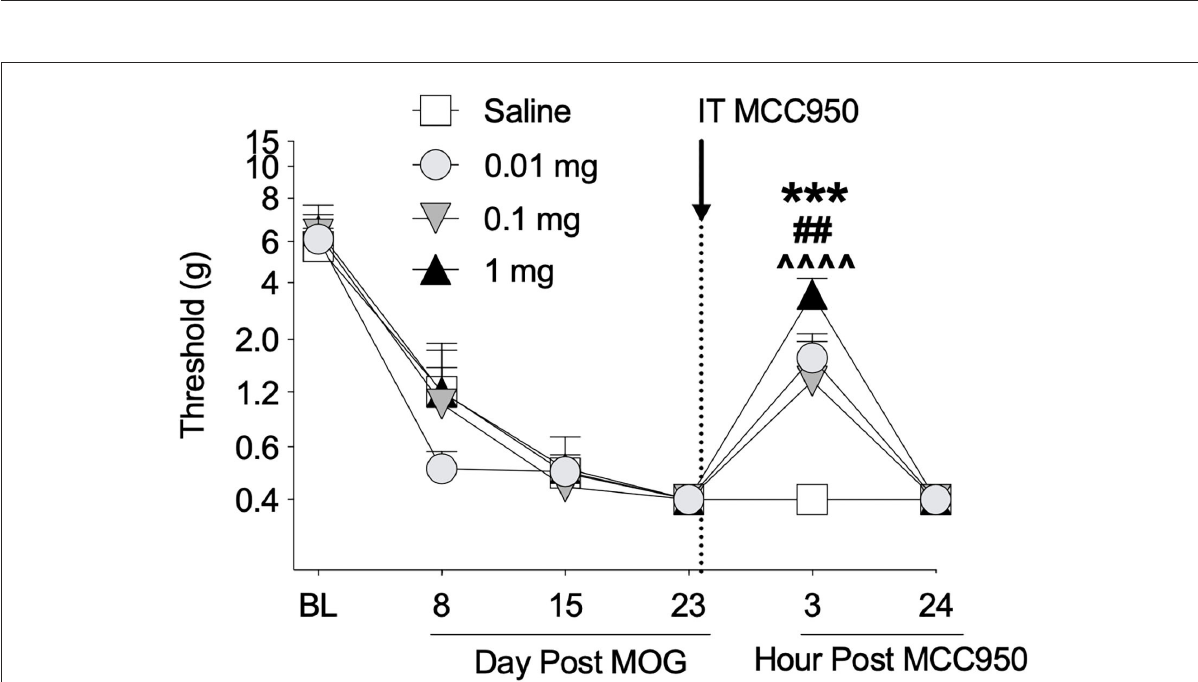
FIGURE5 Intrathecal administration of NLRP3 antagonist MCC950 reverses EAE-related pain in Sprague-Dawley (SD) rats. Sprague-Dawley (SD) rats were baselined (BL) for mechanical withdrawal thresholds via the von Frey test, followed by intradermal low-dose (8 µ g) myelin oligodendrocyte glycoprotein (MOG). MCC950 (0, 0.01, 0.1, 1mg) was intrathecally administered (see dotted line/arrow indicating time of drug delivery), and allodynia was assessed prior to and at 3 and 24h post-MCC950 delivery. Intrathecal administration of all doses of 0.01, 0.1, and 1mg MCC950 on day 23 post-MOG significantly reversed EAE-induced mechanical allodynia at 3h but not 24h post-administration. Main effects of day [ F (5, 70) = 75.78; p < 0.01], MCC950 dose [ F (3, 14) = 4.15; p < 0.05], and interaction between day and MCC950 dose [ F (15, 70) = 2.83; p < 0.01]. N = 4–5/group. Post-hocs : *** indicates significant differences between saline control and 0.01mg MCC950, ## indicates significant differences between saline control and 0.1mg, and ∧∧∧∧ indicates significant differences between saline control and